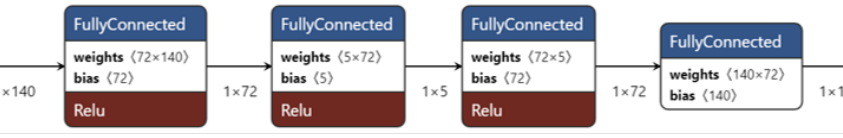
Figure 4. Autoencoder with separated Encoder and Decoder.